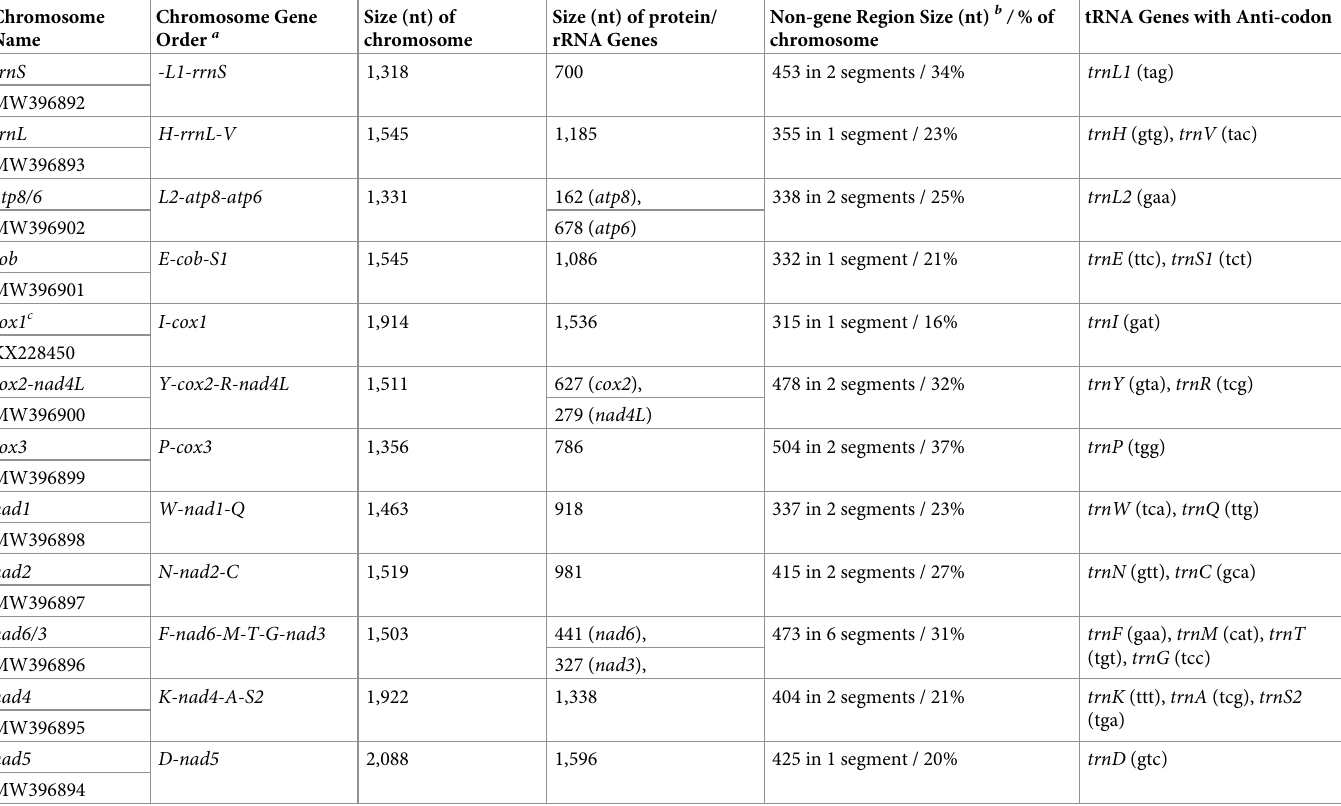
Table 2. Geomydoecus aurei mitochondrial chromosomes, named for their major protein-coding or rRNA genes. Chromosome